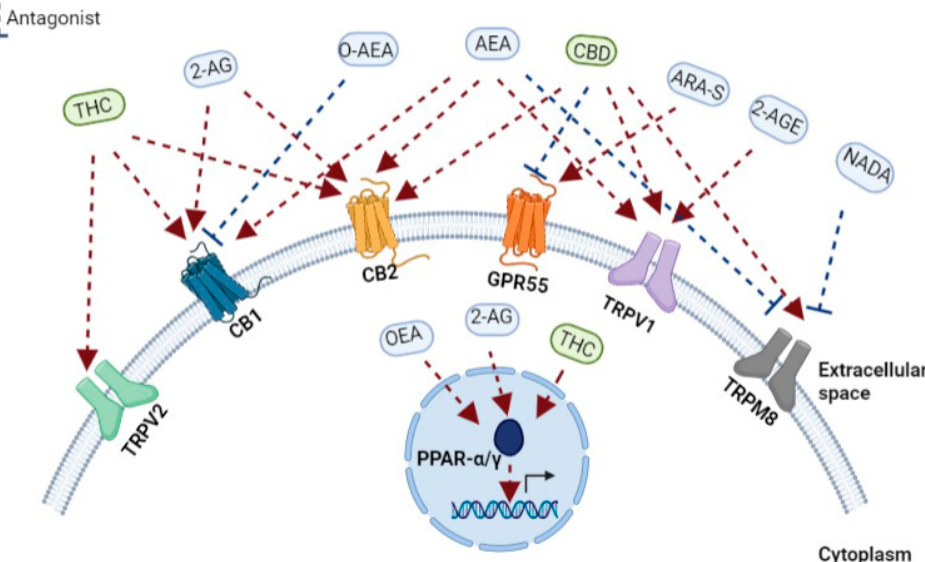
Figure 1. A schematic representation of the main components of the endocannabinoid system. Re- ceptors, endogenous cannabinoids, and cannabis-based components. THC, tetrahydrocannabinol; CBD, cannabidiol; 2-AG, 2-arachidonoylglycerol; O-AEA, virodhamine; AEA, anandamide; ARA-S, N-arachidonoyl serine; 2-AGE, 2-arachidonoyl glycerol ether; NADA, N-arachidonoyl dopamine; TRPV2, transient receptor potential cation channel subfamily V member 2; CB1, cannabinoid receptor 1; CB2, cannabinoid receptor 2; GPR55, G protein-coupled receptor 55; TRPV1, transient receptor potential cation channel subfamily V member 1; TRPM8, transient receptor potential cation channel melastatin 8; PPAR- α , peroxisome proliferator-activated receptor-alpha; PPAR- γ , peroxisome proliferator-activated receptor-gamma.